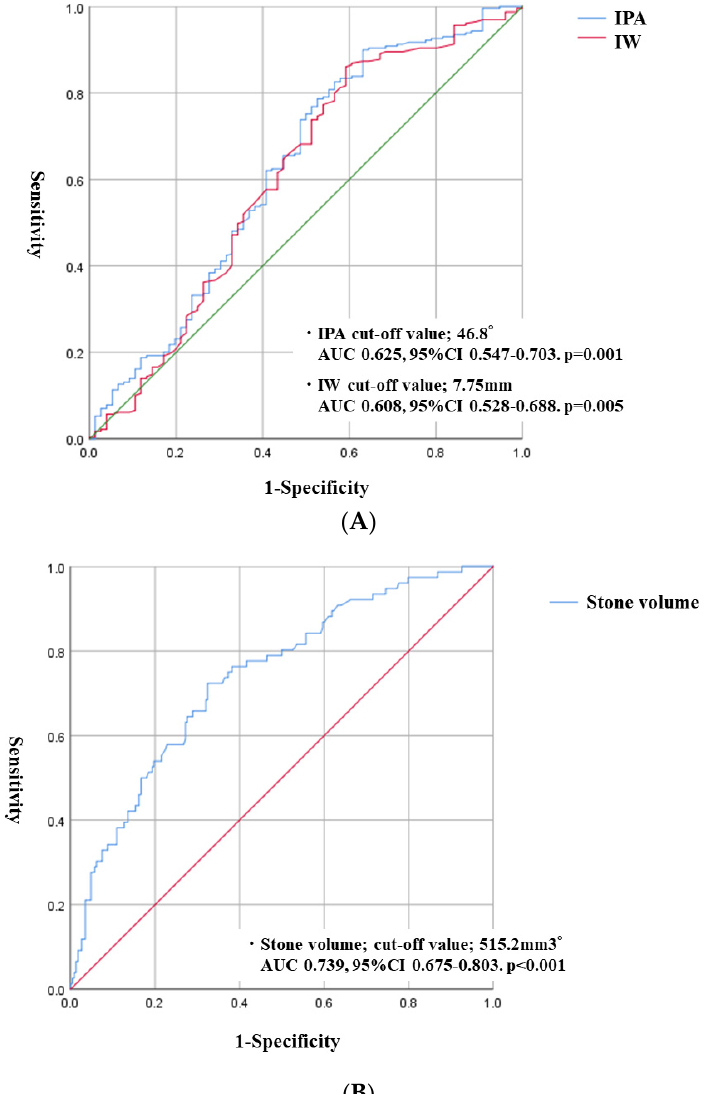
Figure 2. Receiver operating characteristic (ROC) curves used to calculate the optimal cut-off value of continuous variables for accessible lower pole calyces. ( A ) ROC curves indicate the IPA and IW cut-off value. ( B ) ROC curve indicates the cut-off value of stone